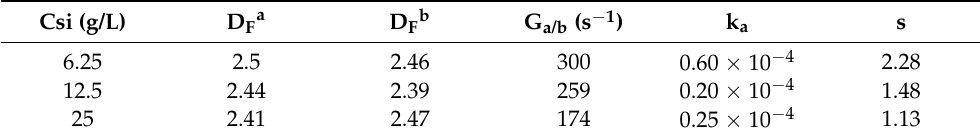
Figure 8. Variation of mean floc diameter with increasing velocity gradient. ( A ) Application of Parker's model (d max = C.G − γ ); ( B ) Application of the model proposed in this study. Table 2. Parameters from the proposed model (Equation (29)) for the relationship between floc size and velocity